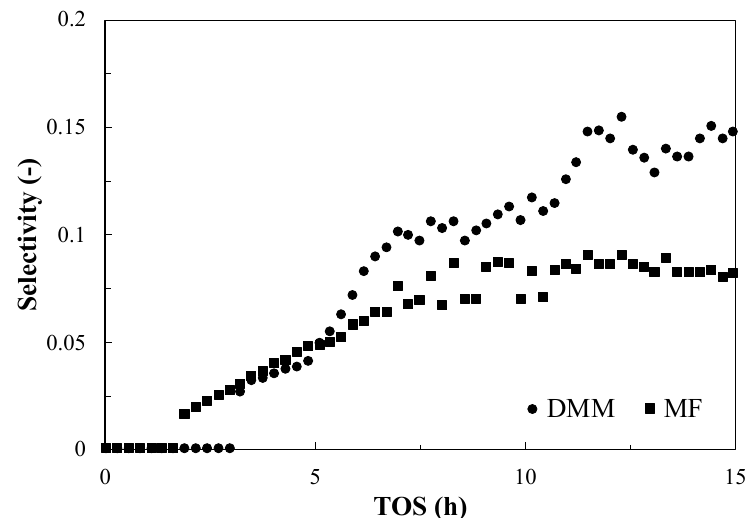
Figure 6. Selectivity toward methyl formate (MF) and dimethoxymethane (DMM) during TOS of the M_ZSM5_A. No appreciable MF and DMM was detected for the other investigated hybrid catalysts.